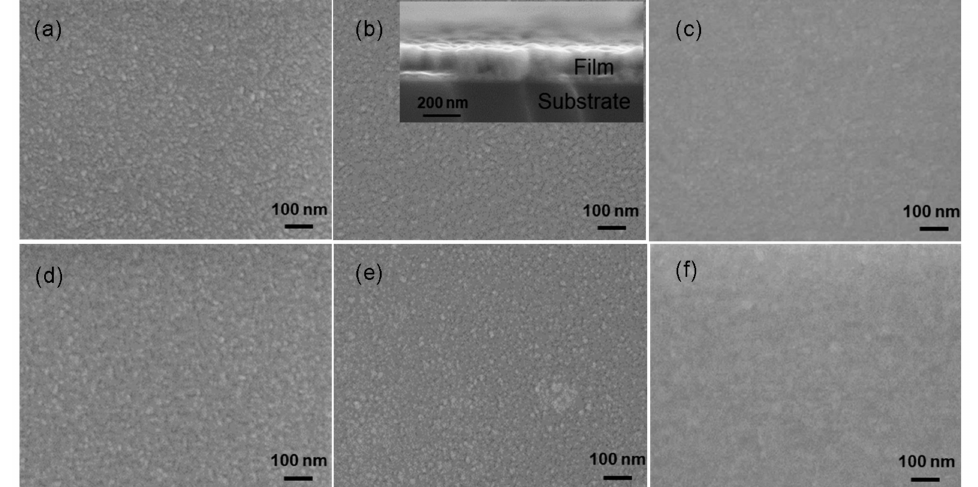
Figure 2. Atomic force microscope (AFM) morphologies of ( a ) as-prepared SnO 2 film, ( b ) vacuum-annealed SnO 2 film, ( c ) air-annealed SnO 2 film, ( d ) as-prepared SnO 2 :F film, ( e ) vacuum-annealed SnO 2 :F film and ( f ) air-annealed SnO 2 :F film.